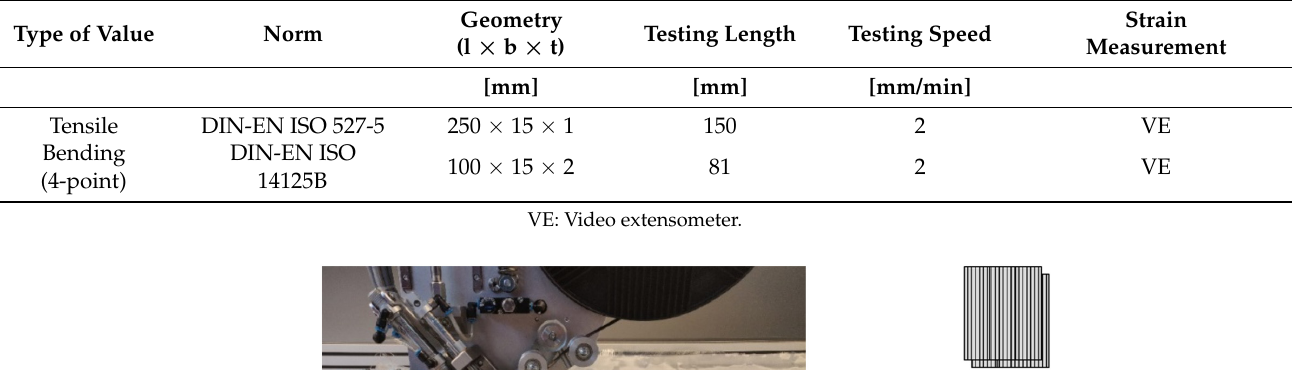
Table 4. Norm for testing, specimen geometry, and test parameters.